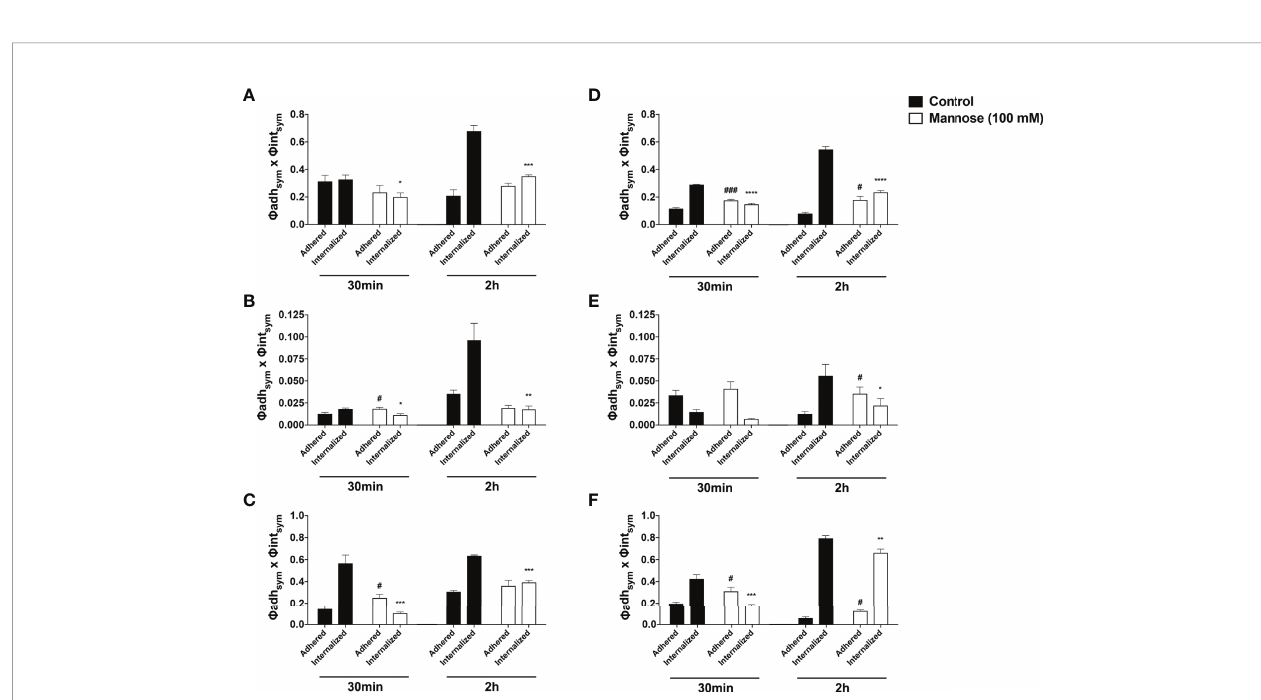
FIGURE 8 | The mannose receptors participates on fungal internalization by Acanthamoeba castellanii and macrophages Phagocytosis assays were performed with either (A – C) A. castellanii or (D – F) RAW 264.7 upon addition of NHS-Rhodamine labeled (A, D) Candida albicans , (B, E) Cryptococcus neoformans and (C, F) Histoplasma capsulatum , in the absence (Control group, black bars) and presence of 100 mM soluble mannose (Mannose 100 mM, white bars) and analyzed after 30 min, to evaluate the initial fungal adhesion, and 2h, to evaluate the late interaction. Symmetrized adhesion and phagocytic indices were determined and the mannose inhibition groups were compared to controls. The statistical signi fi cances are represented above each group, where *p < 0.05, **p < 0.01, ***p < 0.001 or ****p < 0.0001 indicate statistically signi fi cant decrease upon mannose inhibition; # p < 0.05, ### p < 0.001 indicate statistically signi fi cant increase upon mannose inhibition; ns = not signi fi cant). The bars represent the average of three independent experiments, performed in